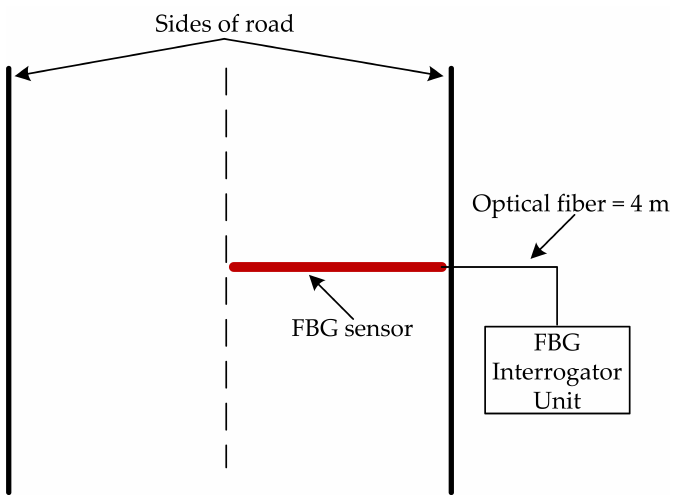
Figure 4. Measuring scheme of experimental